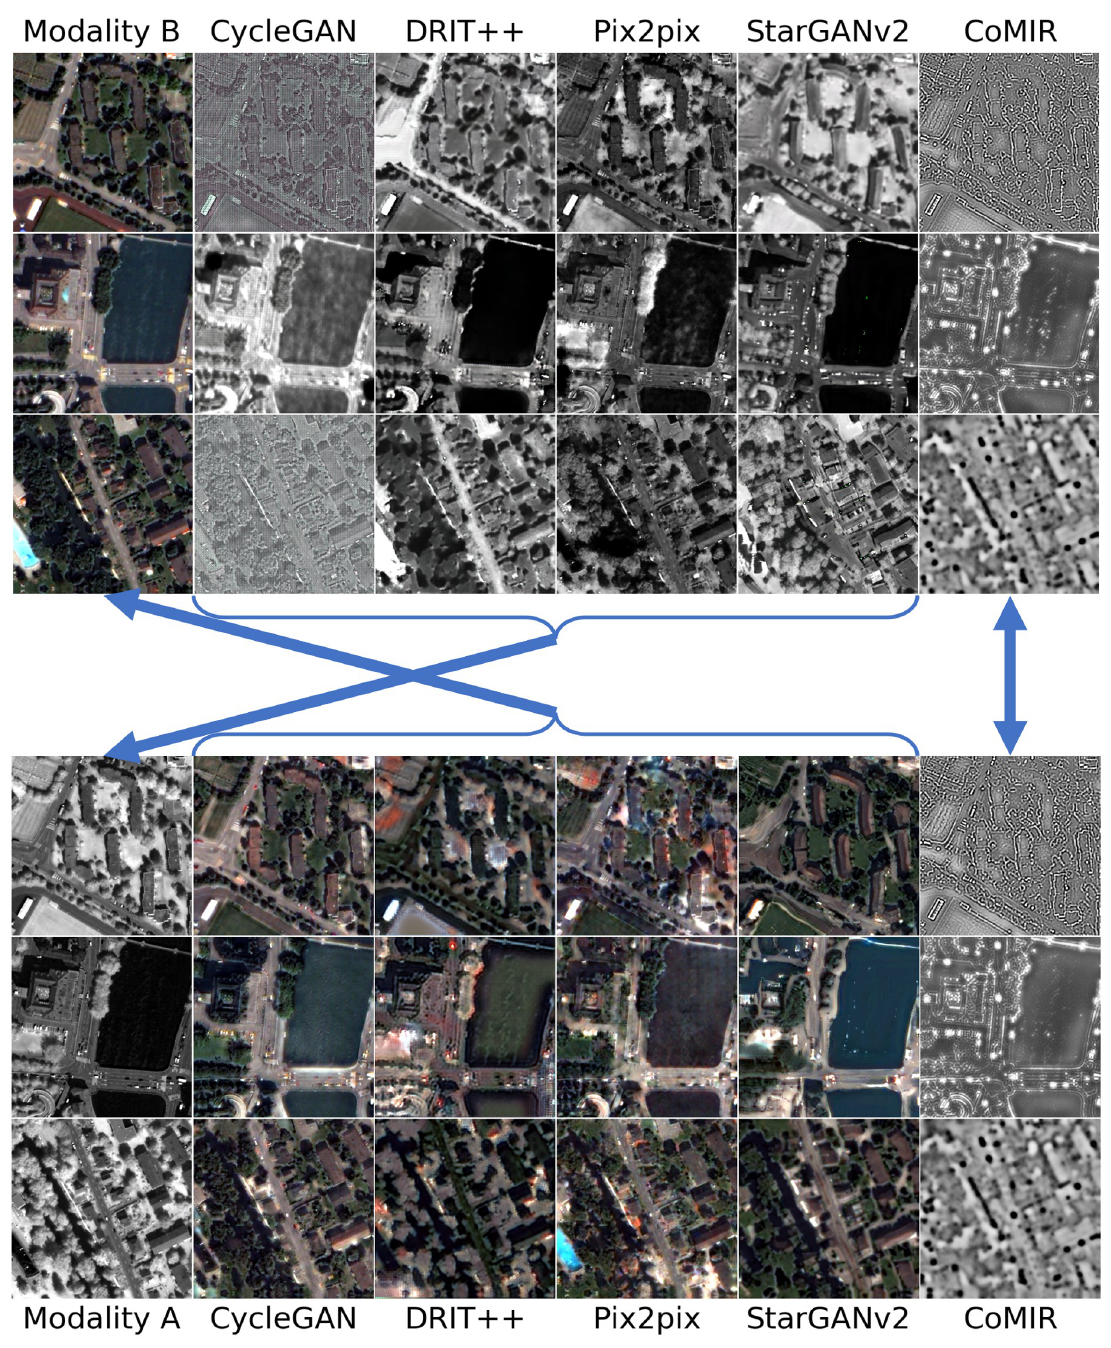
Fig 4. Modality-translated image samples of the Zurich dataset by different evaluated methods (contrast-enhanced for visualisation). Each row shows the results on one random image from each fold. Images in Columns 2–6 are generated from the images in (the corresponding row of) Column 1. Top block: Translations generated from Modality B. Bottom block: Translations generated from Modality A. The arrows indicate what to compare for visual inspection of the level of achieved similarity (pointing from generated images to the corresponding target of the learning